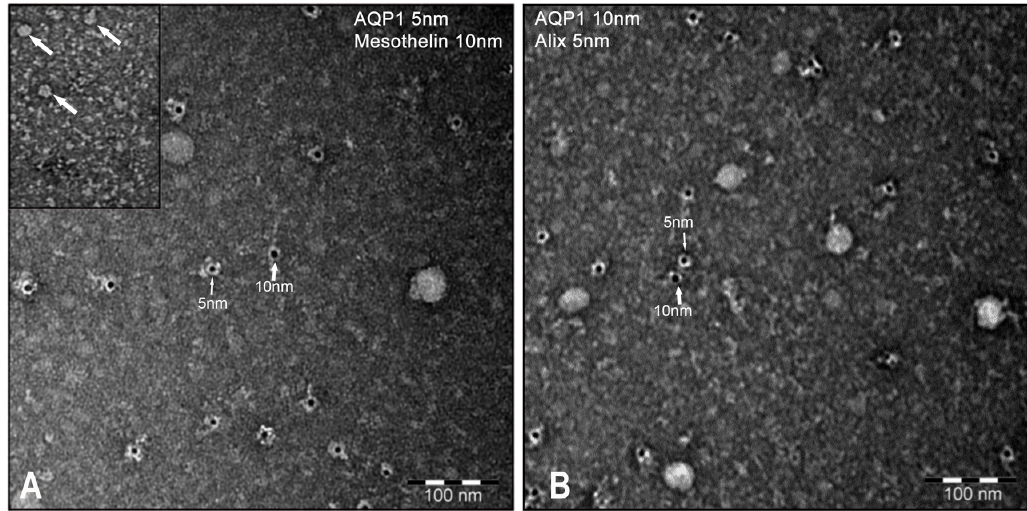
Figure 3. PD effluent-isolated vesicles were fixed, adsorbed on nickel grids and analyzed by